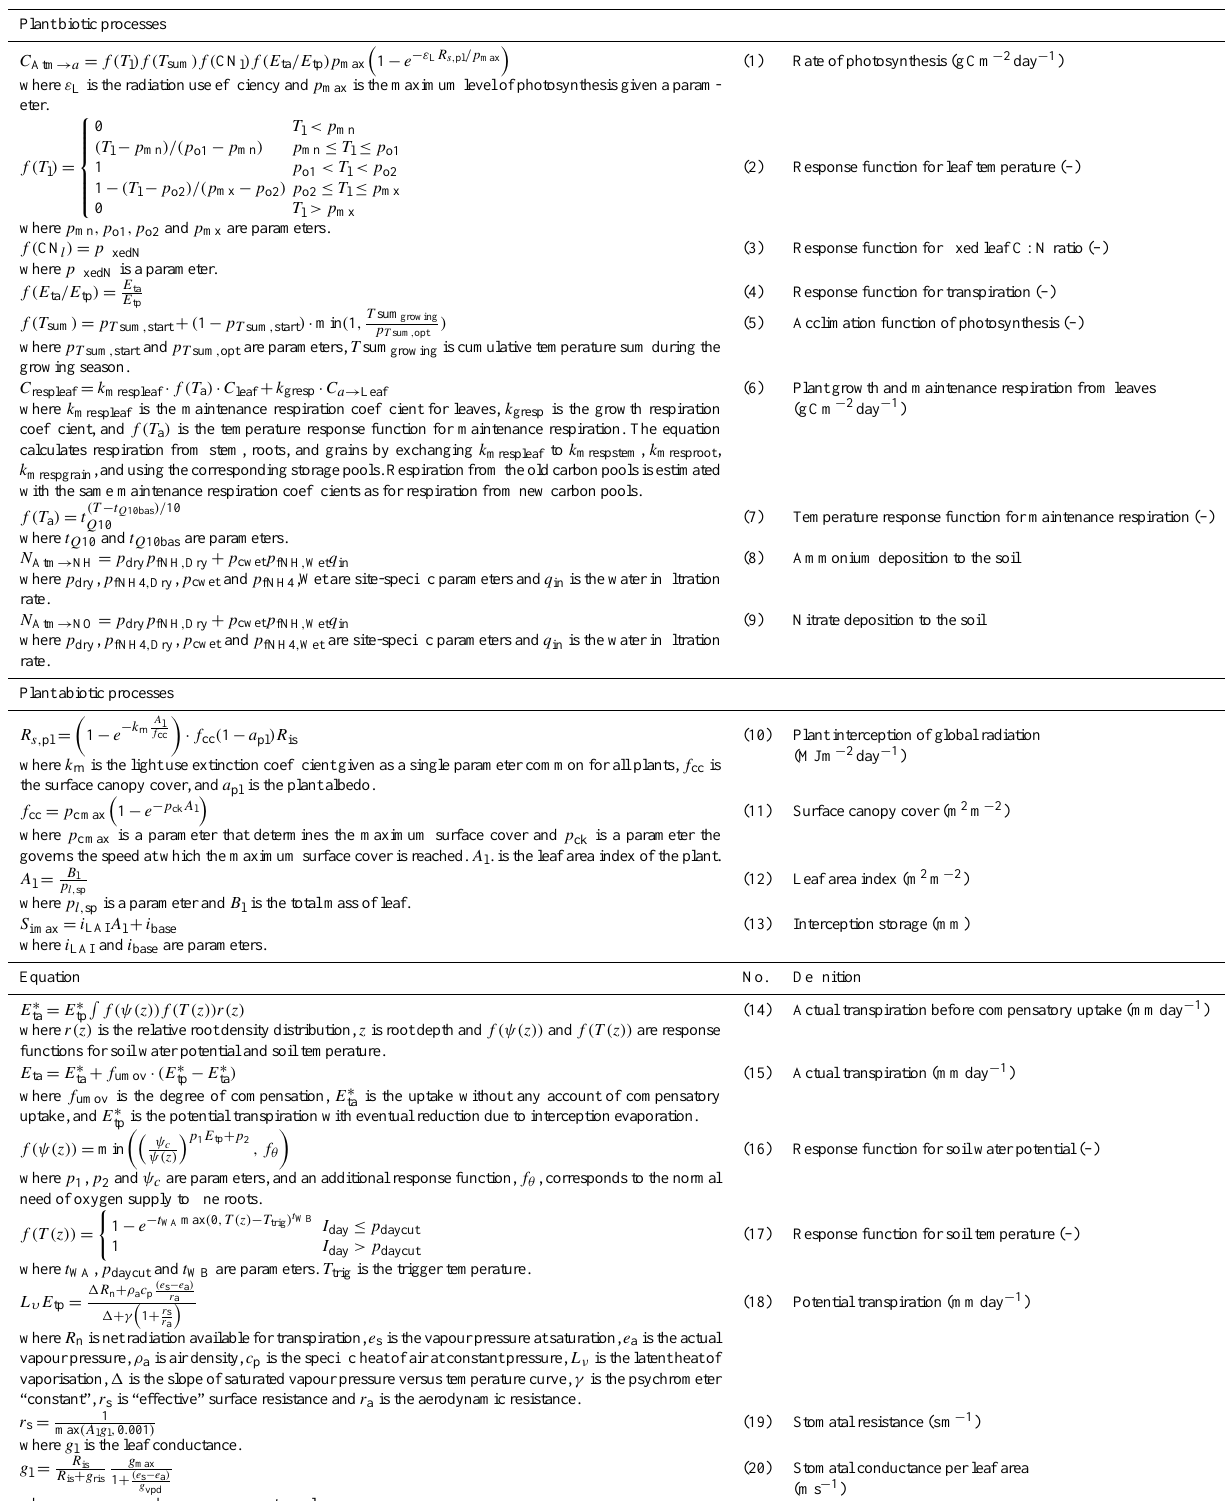
Table 1. List of equations used in this